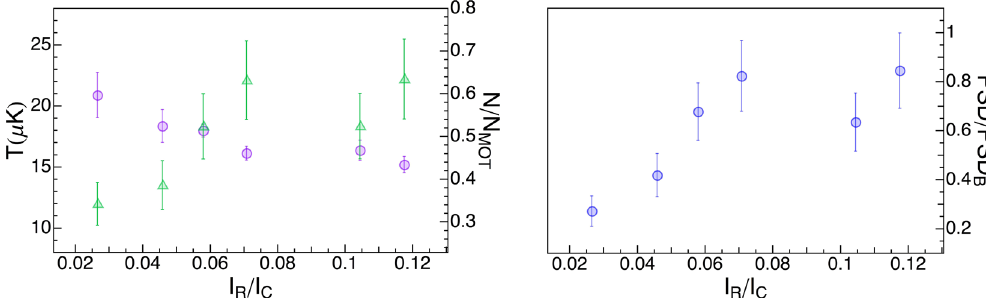
Figure 2. Effect of repumper intensity. Left: Temperature T (purple circles) and ratio between atom number after and before the molasses N / N MOT (green triangles) as a function of the intensity ratio I R / I C between repumper and cooler light; Right: PSD measured after grey molasses normalized to the value of the bright molasses ( PSD B